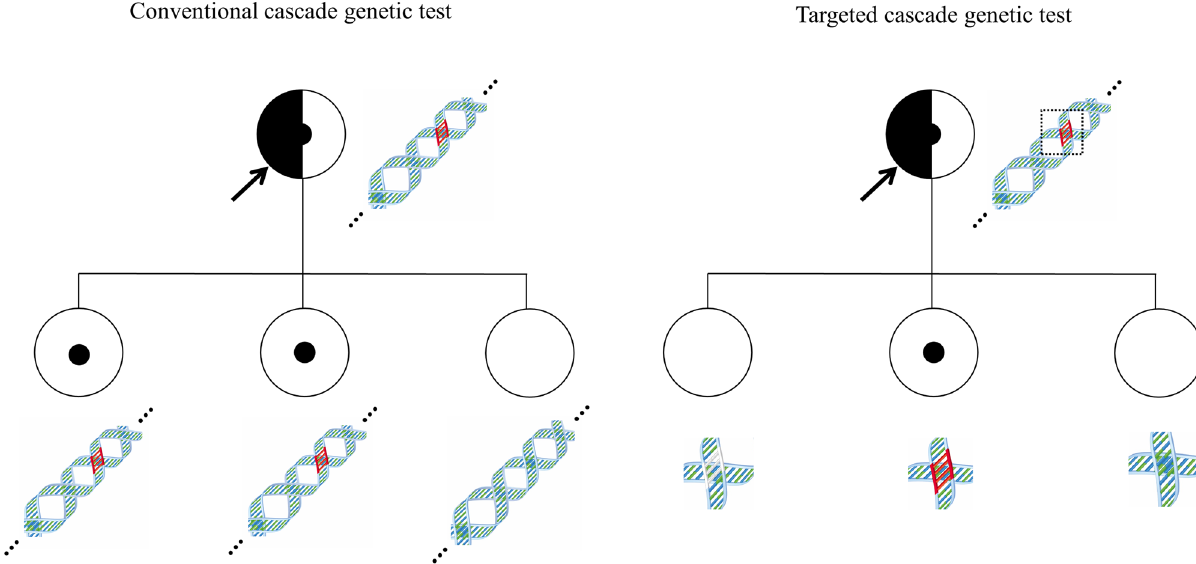
Figure 2. Definition of conventional and targeted genetic cascade test for BRCA1/2 genes. The conventional cascade genetic testing is defined as testing the relevant genes for blood relatives, whereas targeted cascade testing for BRCA1/2 gene was defined as testing only a part of exon with PV or LPV of blood relatives of the index patient with BRCA1/2 gene PV or